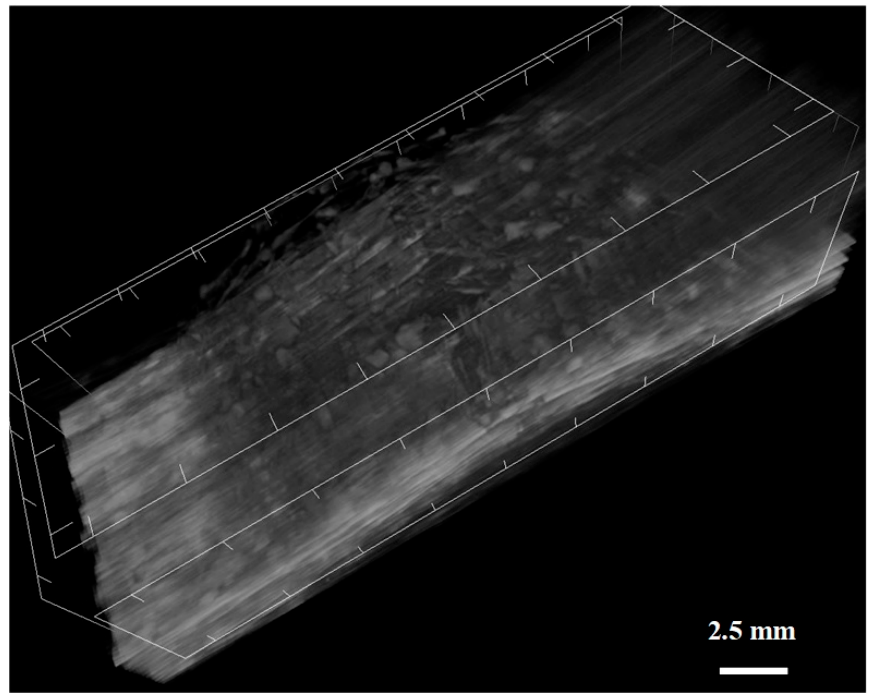
Figure 5. Three dimensional (3D) image after impact test of carbon fiber reinforced geopolymer composite. The part shows the area of impact.